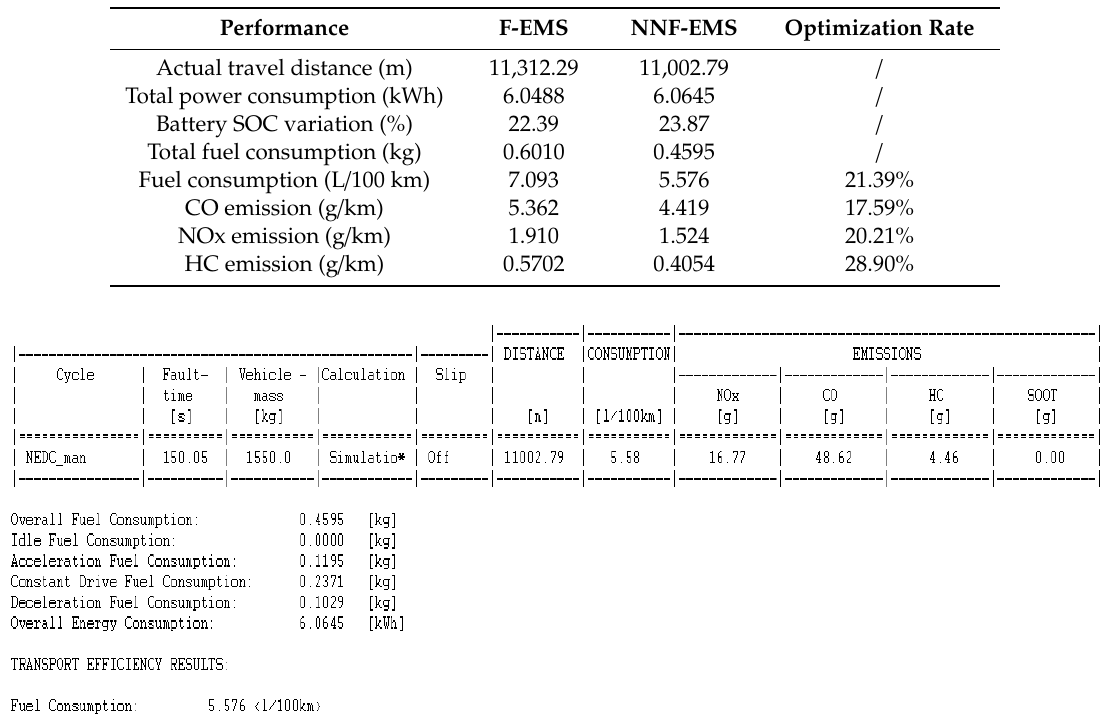
Figure 19. Simulation results of neural network fuzzy energy management strategy (NNF-EMS) under NEDC cycles in AVL Cruise.